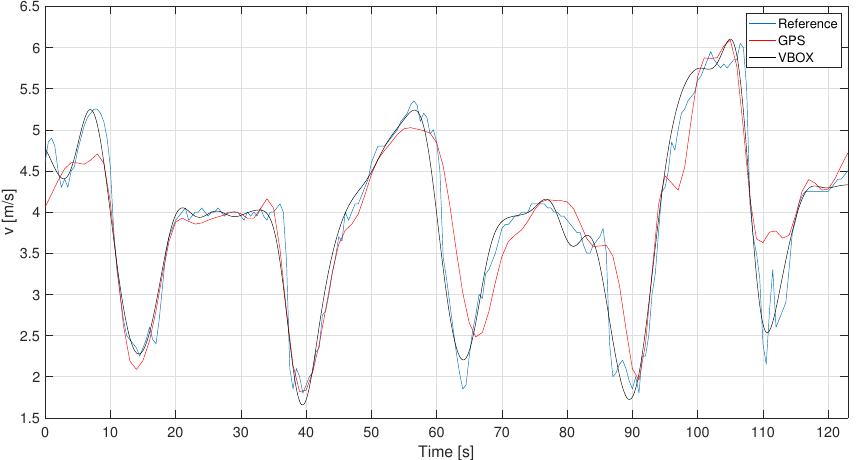
Figure 6. C1—Reference, GPS and VBOX speed signals. The steps discussed above, i.e., denoising, outlier removal and filtering, are now applied for the acceleration signals. GPS and VBOX accelerations, derived from the speed signals, are evaluated and compared to the reference acceleration profile, as Figure 7 depicts. The accelerations are calculated as derivative of the raw velocities to avoid the useful information is lost during their calculations. Furthermore, for sake of visualization, the VBOX raw acceleration signal has been denoised according to previous discussed.